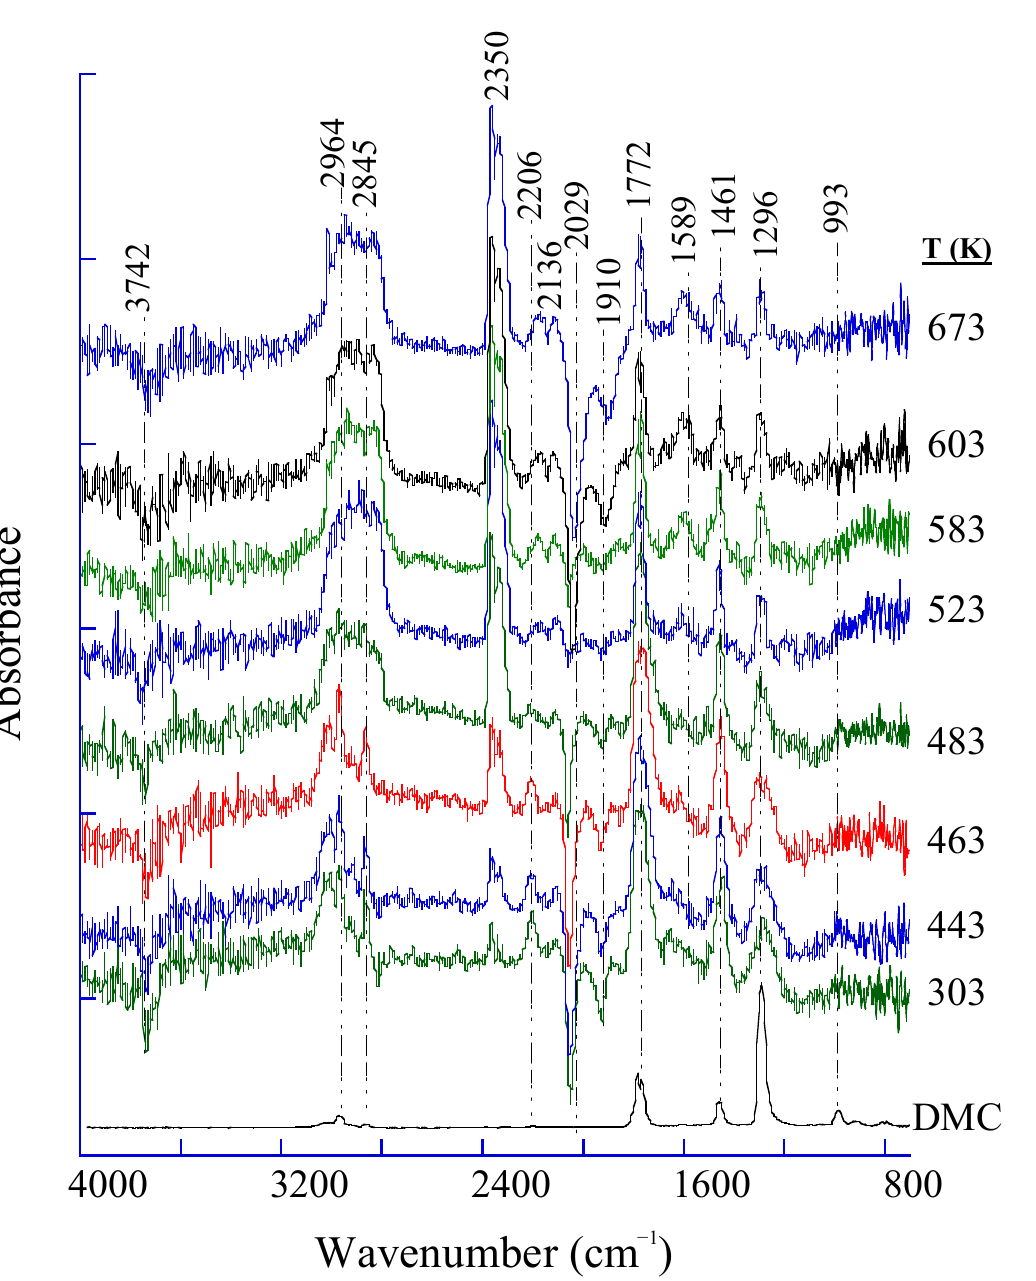
Figure 8- IR spectra during the exposure of the Rh/Al 2 O 3 catalyst to DMC flow at different temperatures.